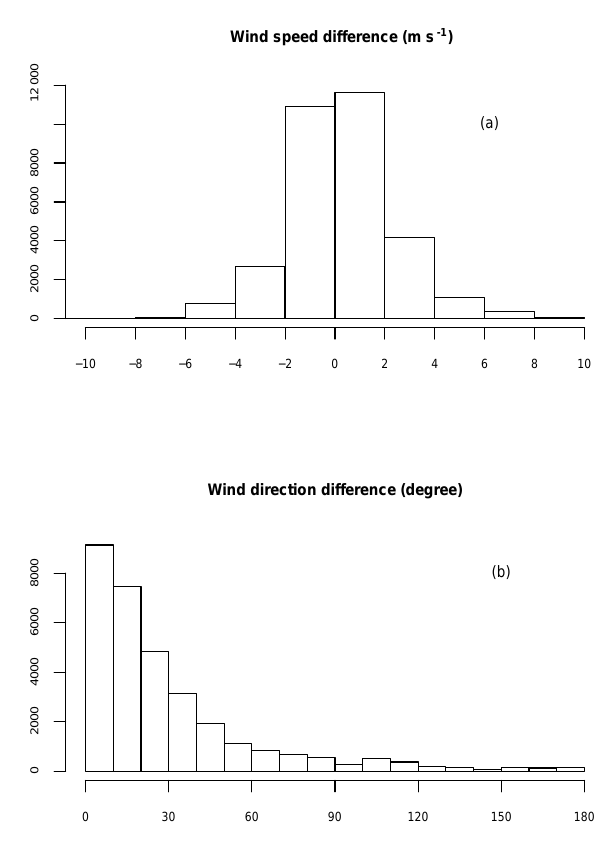
Figure 6. Histograms of the 10m wind speed difference (a) and wind direction difference (b) between the WRF simulation and sur- face meteorological station